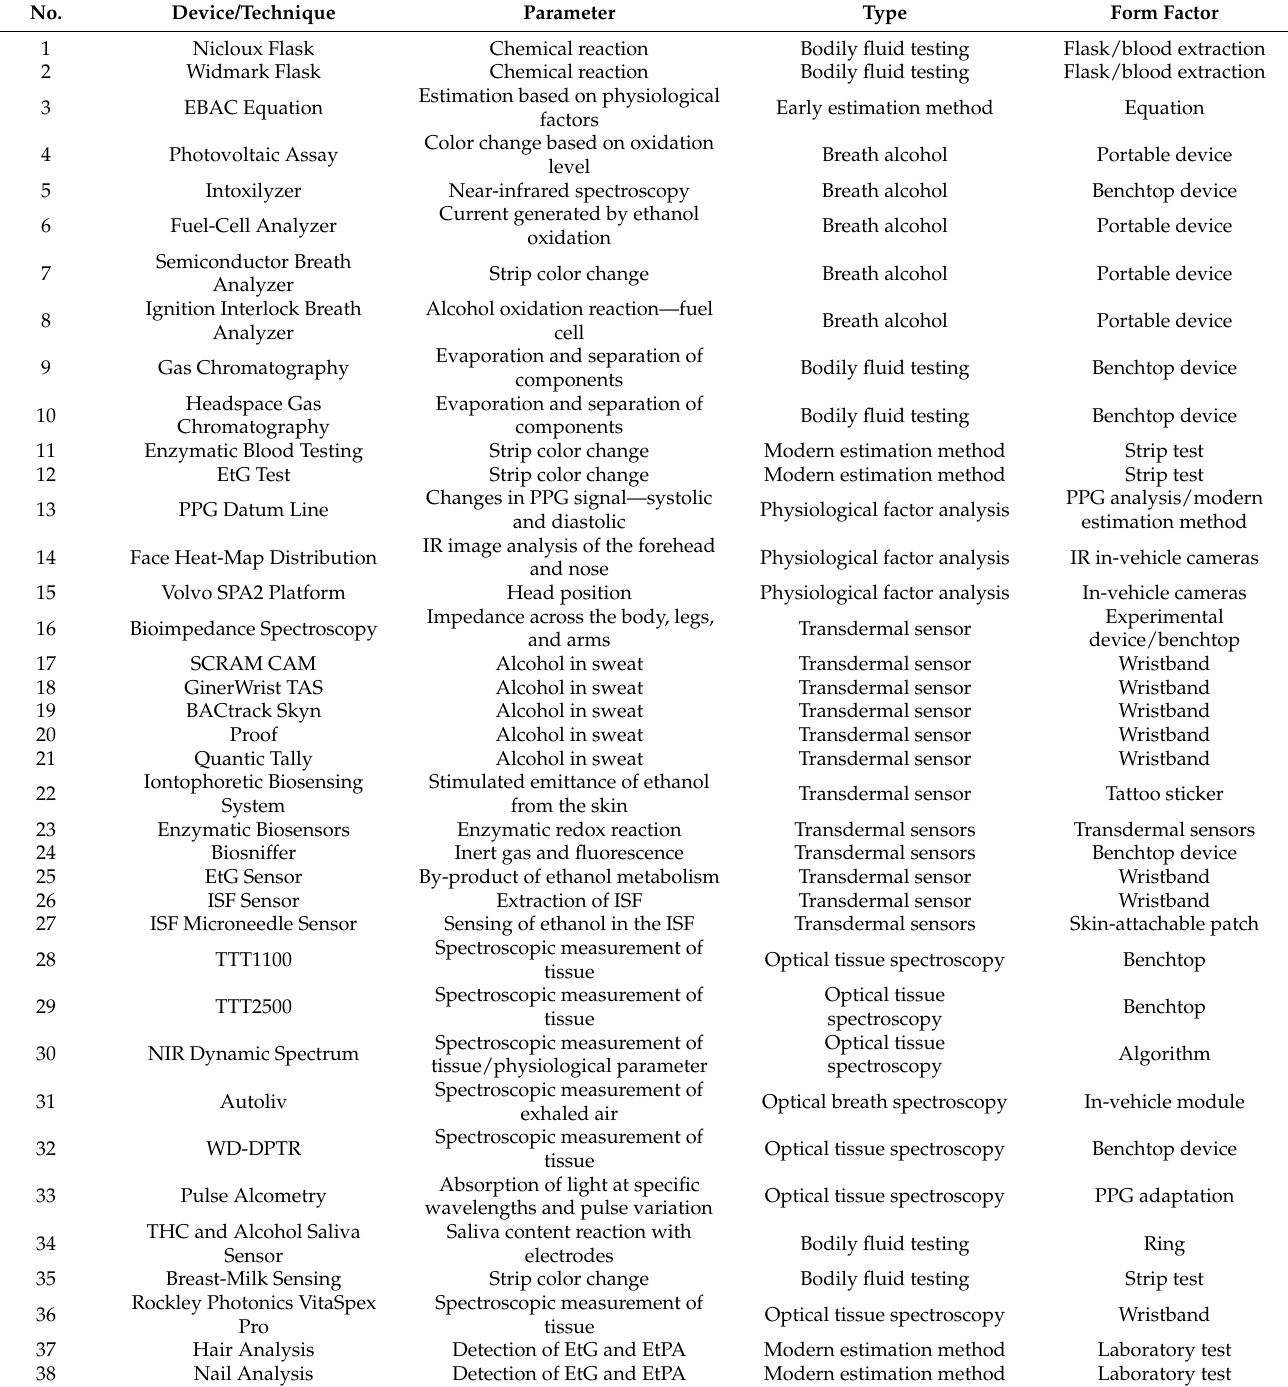
Table 1. Summary of ethanol detection devices and